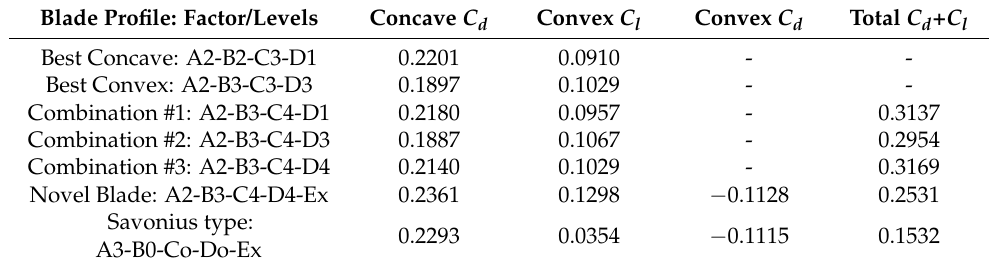
Table 10. Analysis results summary.